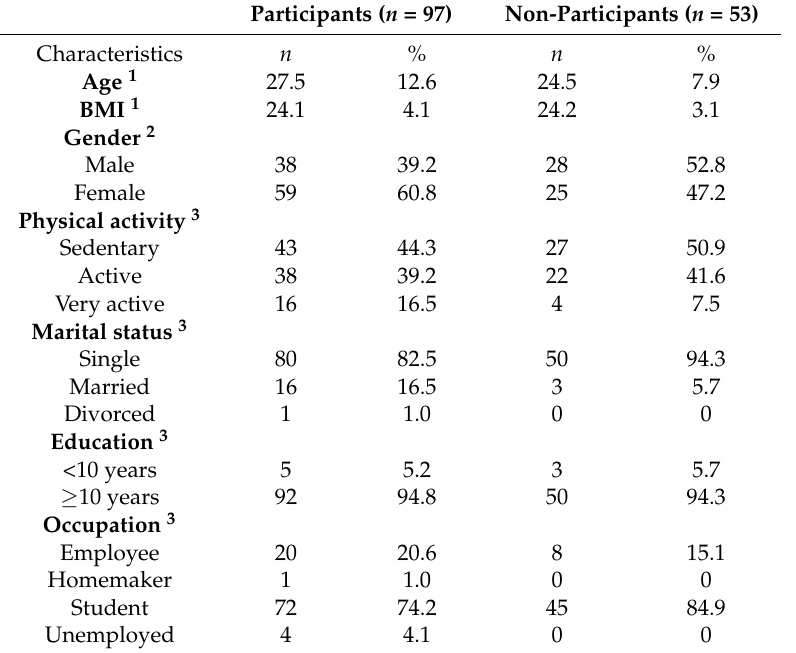
Table 2. Characteristics of participants who completed the study ( n = 97) and those who did not complete ( n =